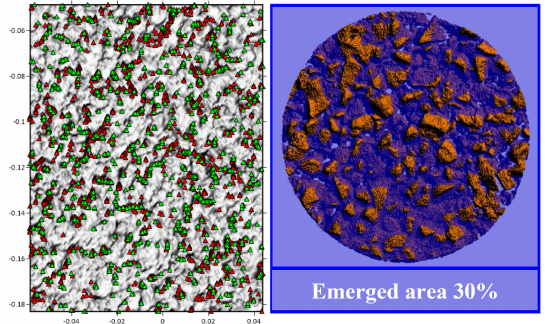
Figure 5. Examples of the analysis on the 3D models of an asphalt specimen: on the left, peaks (in red) and valleys (in green) automatically extracted for the determination of texture indicators; on the right, flood simulation on a specimen to calculate the emerged area (right image).